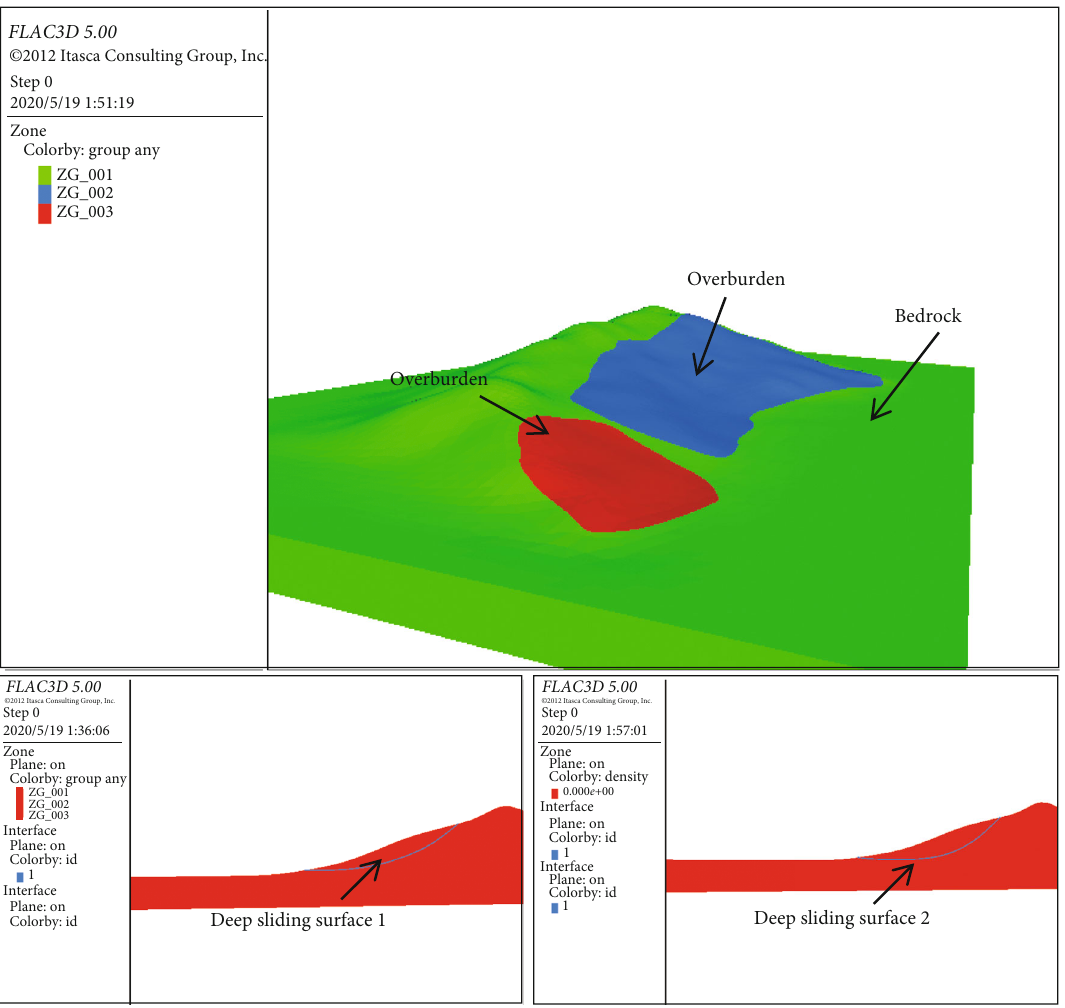
Figure 7: FLAC calculation model diagram.